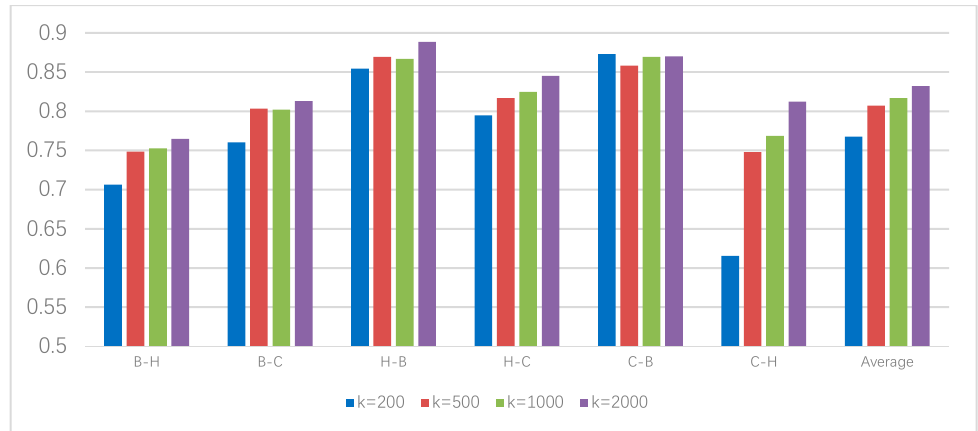
Figure 3. Accuracy results obtained by adding different numbers of target domain samples.